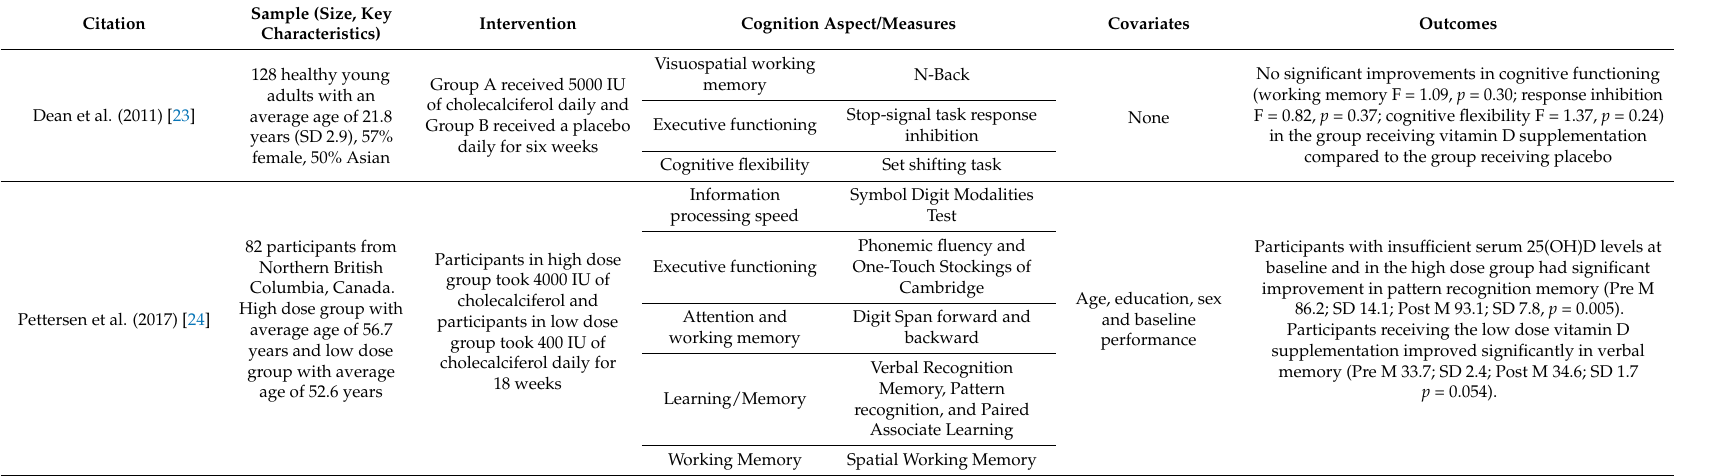
Table 3. Randomized control trials examining effects of serum 25(OH)D supplementation on cognitive